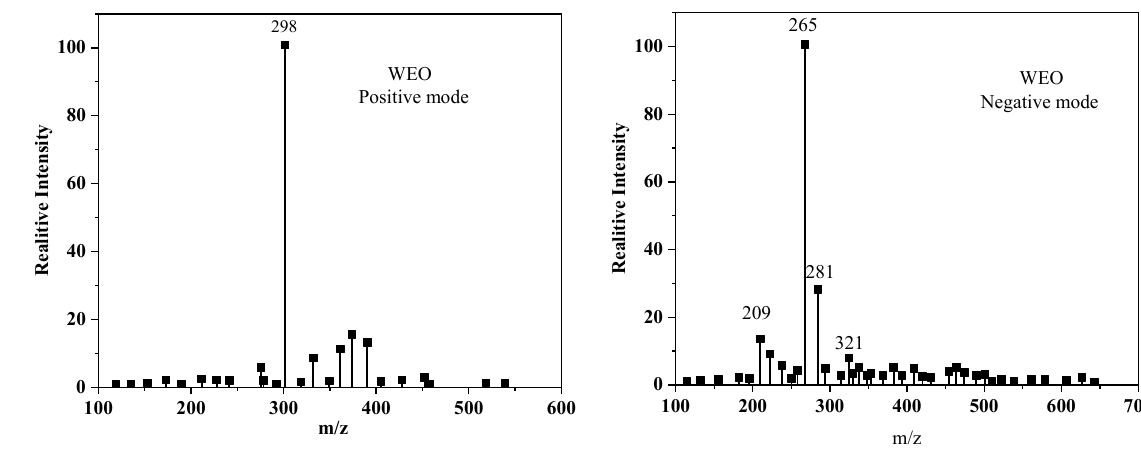
Figure 6. Molecular weight of WEO.